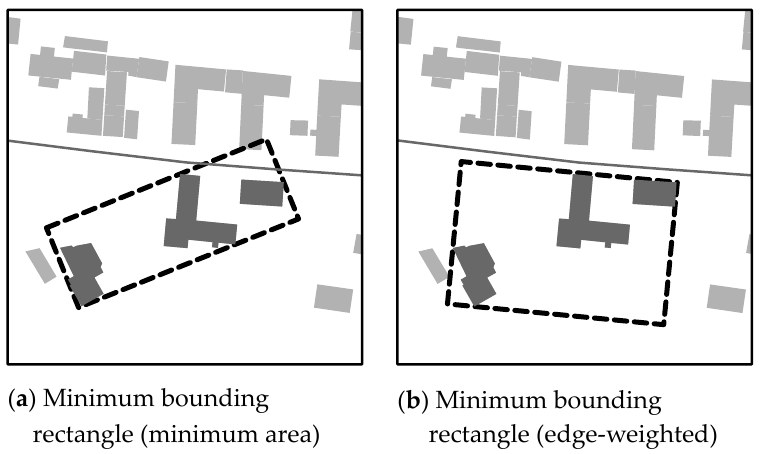
algorithm for creating minimum enclosing rectangles. ( Source : own compilation based on data from official building polygons, ATKIS ® Base-DLM © Geobasis-DE/BKG (2017)).